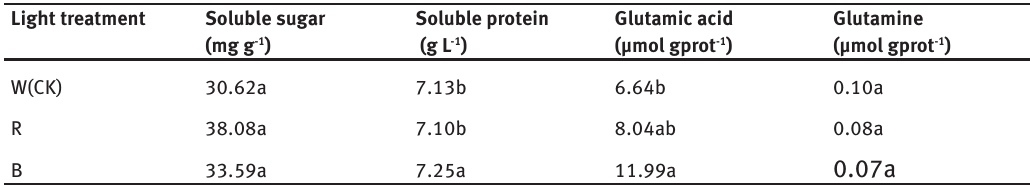
Table 3: Effects of 24 h continuous light on content of nitrogen metabolites in pakchoi. Light